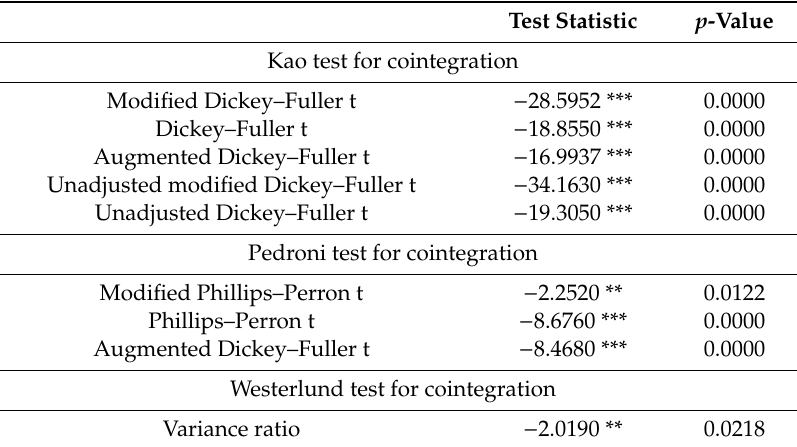
Table 6. Cointegration tests for model 2 (Equation